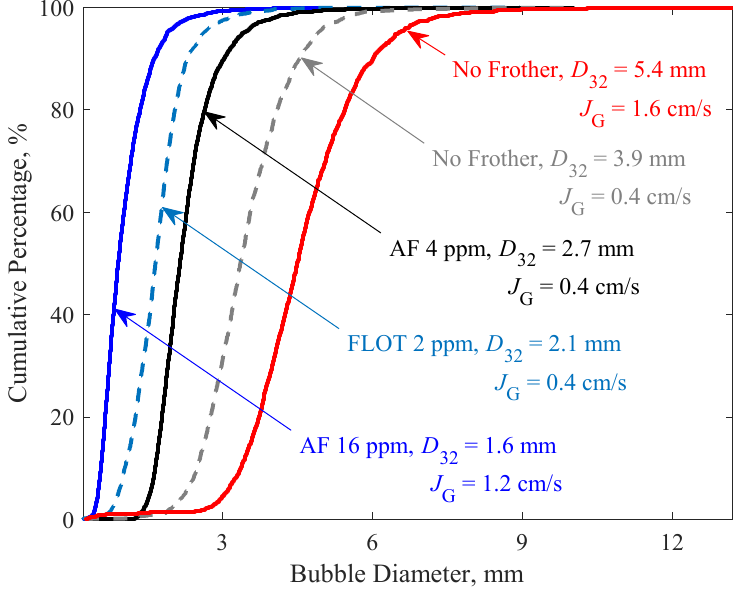
Figure A1. Examples of bubble size distributions in the laboratory tests.